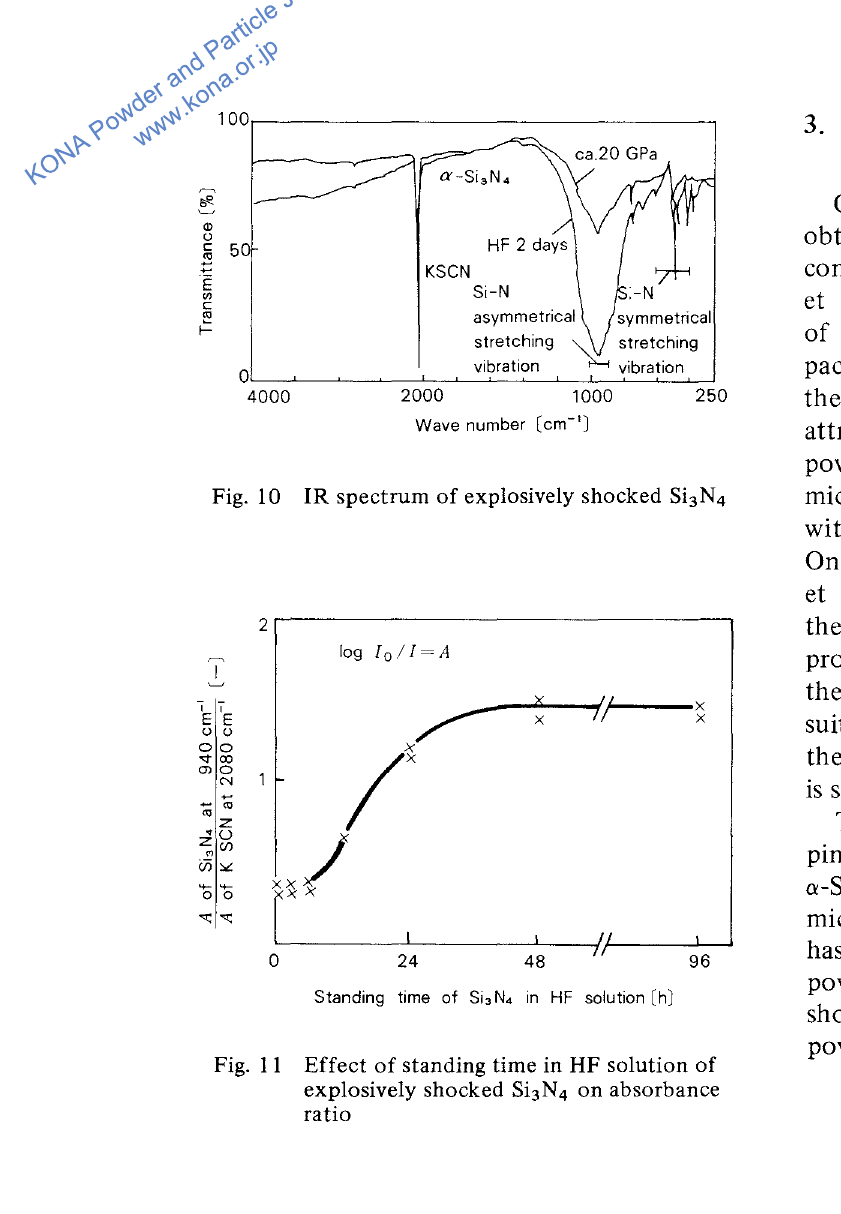
Fig. 10 IR spectrum of explosively shocked Si 3 N 4